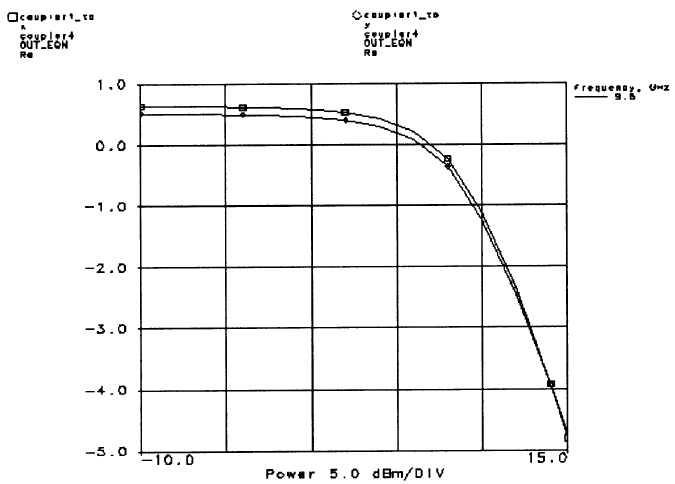
FIGURE 26 Transmission gain vs. the power of the LO input signal.